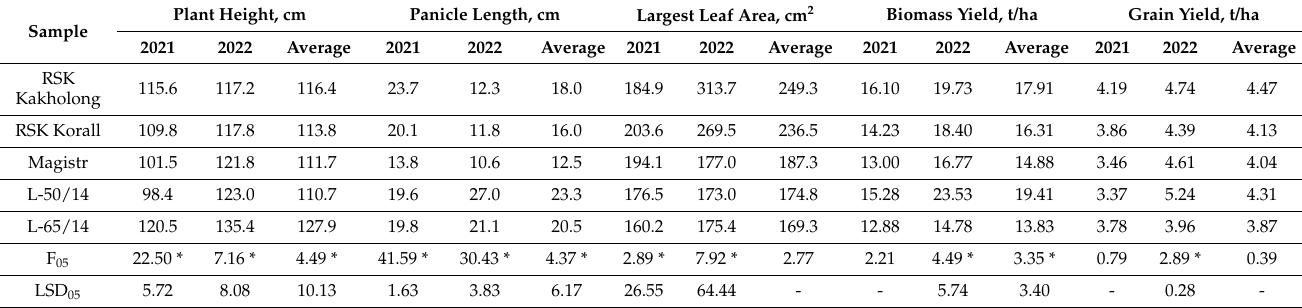
Table 6. Morphometric traits and yield of grain sorghum samples